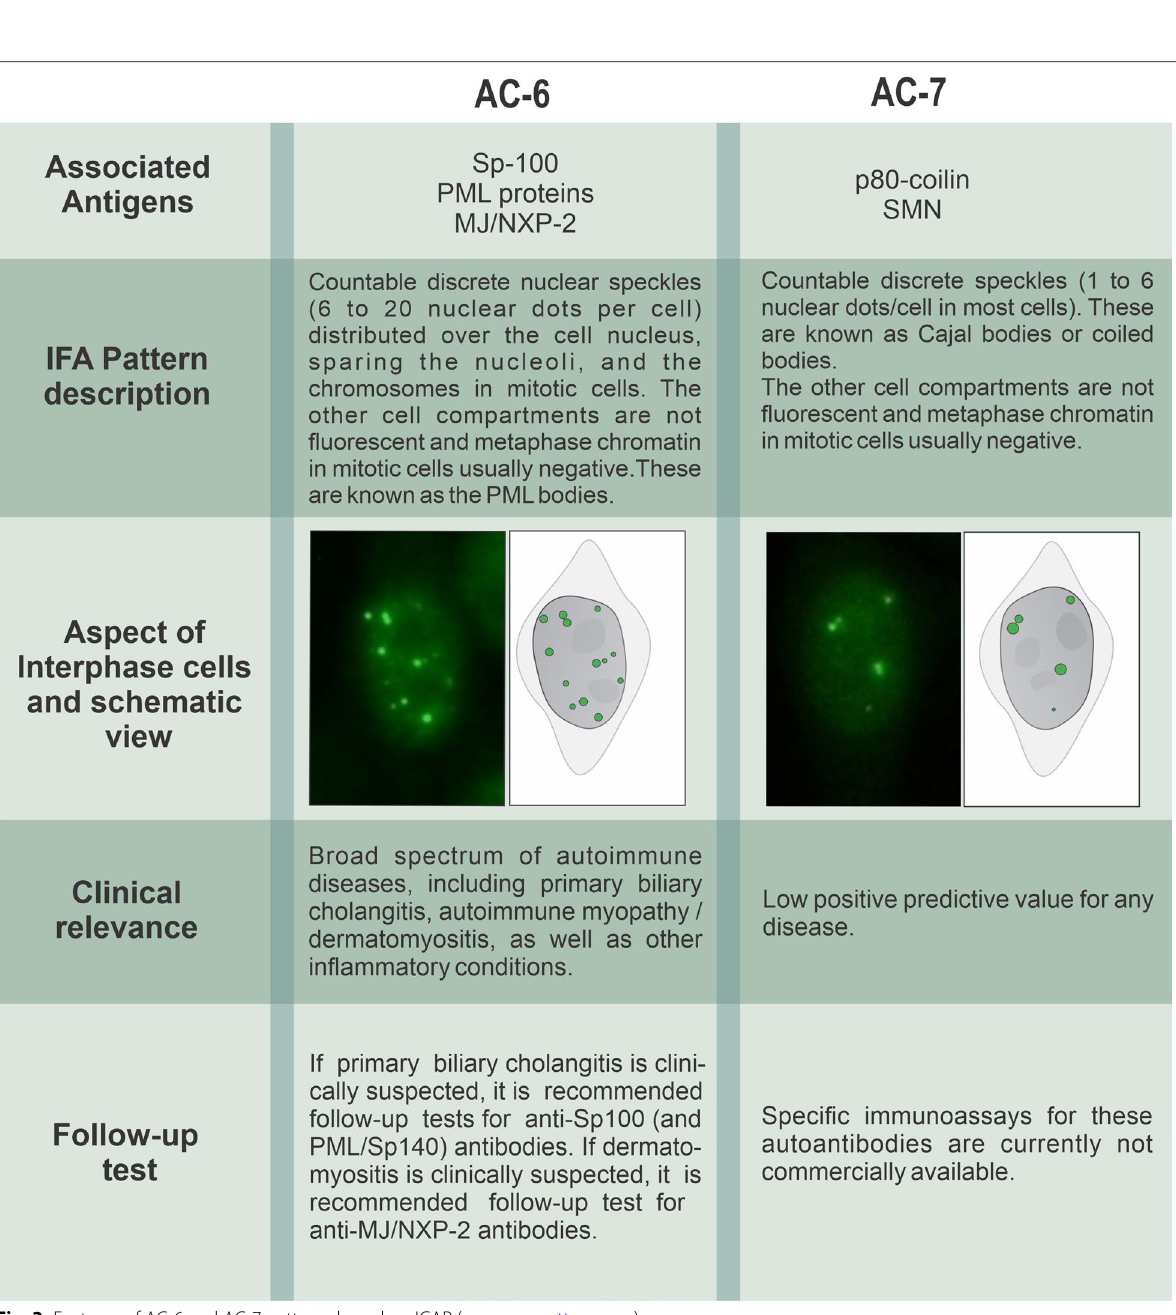
Fig. 3 Features of AC-6 and AC-7 patterns based on ICAP (www. anapa tterns.